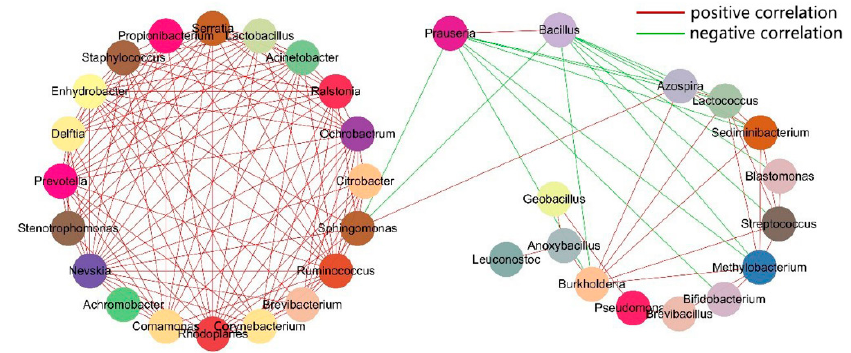
Figure 7. Correlation analysis of the 50 most abundant genera in VF, WH, and ST.